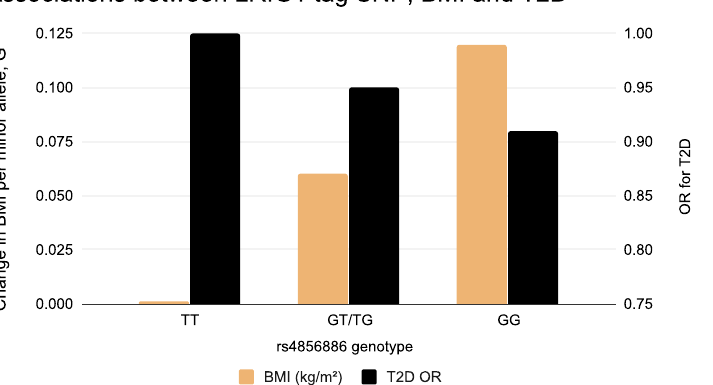
mutants for LRIG/sma-10 . As a BMP pathway-independent control for short body length, we included the cuticle collagen mutant dpy-5(e907) in our analysis 43 . Both body length and fat accumulation were assessed in wild-type and mutant worms (Fig. 6a – c). As expected, compared to wild-type worms, all of the dpy-5 , sma-10 , daf-4 , sma-6 , and sma-3 mutant worms showed a reduced body length (Fig. 6a, b). Intriguingly, compared to lipid accumulation in wild-type worms, lipid accumulation was reduced in both the LRIG / sma-10 mutants wk88 and wk89 , in the ACVR2A and ACVR2B homolog mutant daf-4(m63) and in the SMAD1 homolog mutant sma-3(wk30) (Fig. 6a, c). Compared to the wild-type, also the BMPR1A / sma-6(wk7) mutants showed an apparent, although nonsigni fi cant ( p = 0.14), reduction in lipid